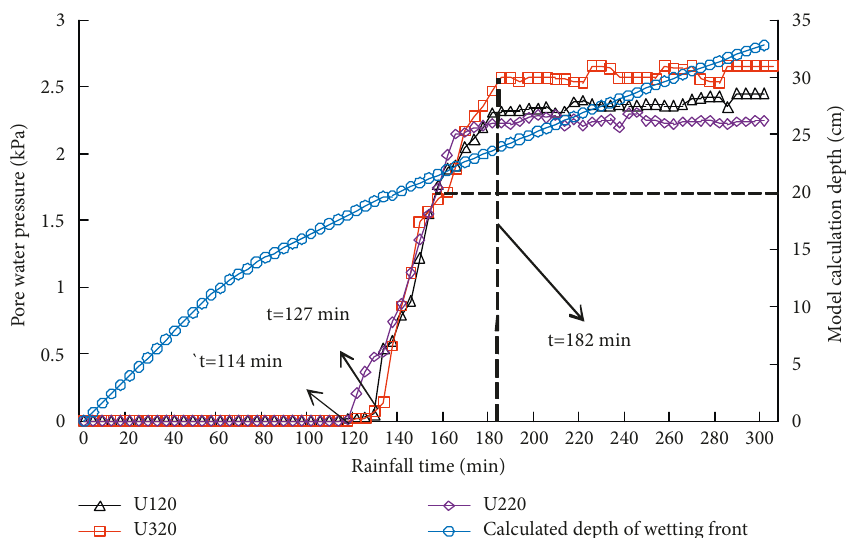
Figure 9: Pore water pressure and calculated depth in different locations at the same depth.